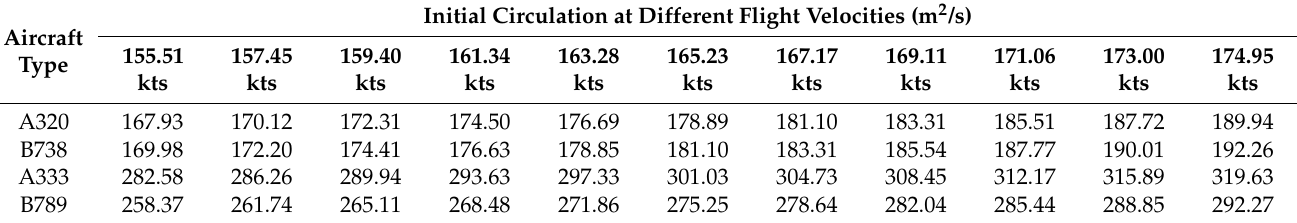
Table 2. Initial circulation of each aircraft at different